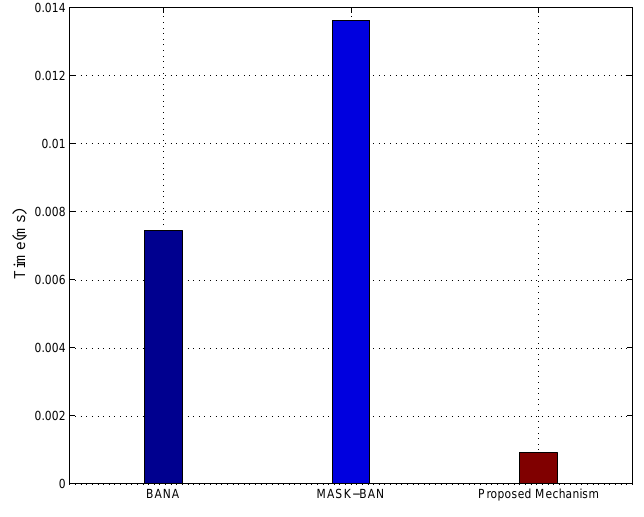
Figure 10. Complexity benchmarking based on execution